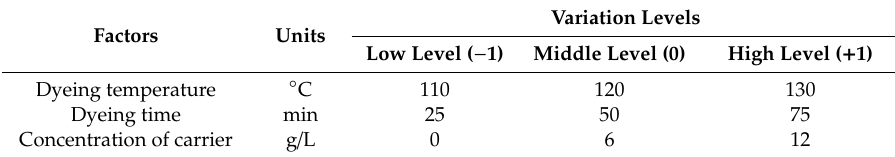
Table 3. Factors and levels used in the Box-Behnken experimental design.